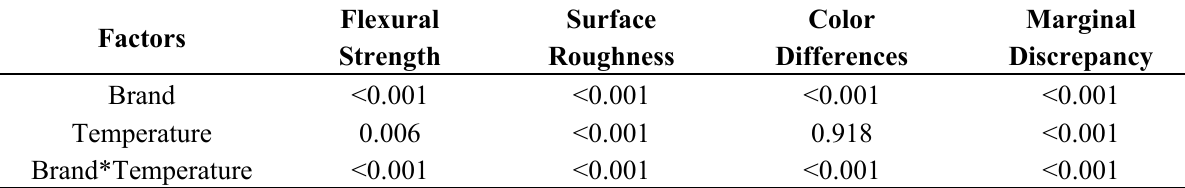
Table 1. The p -values of main effect comparison between-subjects test of two-way